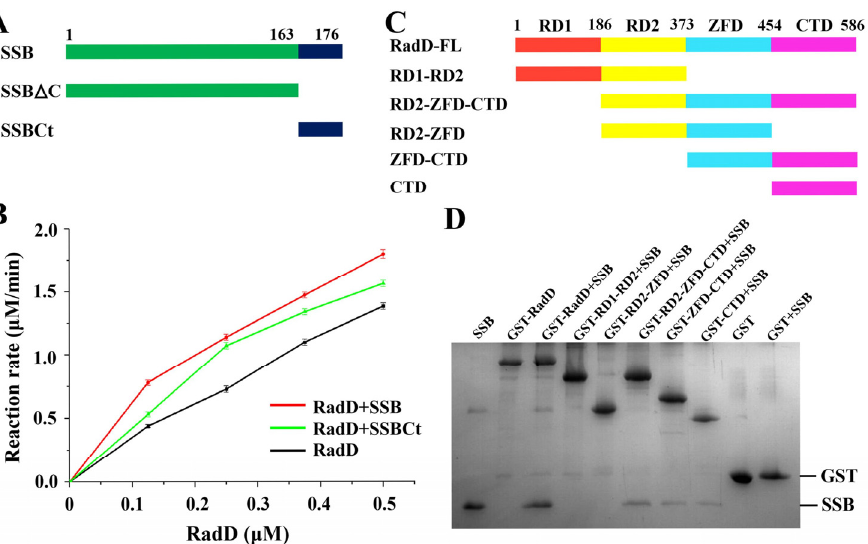
Figure 4. Interaction between RadD and SSB. ( A ) Schematic of SSB domains. ( B ) SSB or SSBct increases the ATPase activity of RadD. ( C ) Schematic of RadD domains. ( D ) Assays of RadD and SSB interactions by GST pull-down. SDS-PAGE is stained using Coomassie Blue.